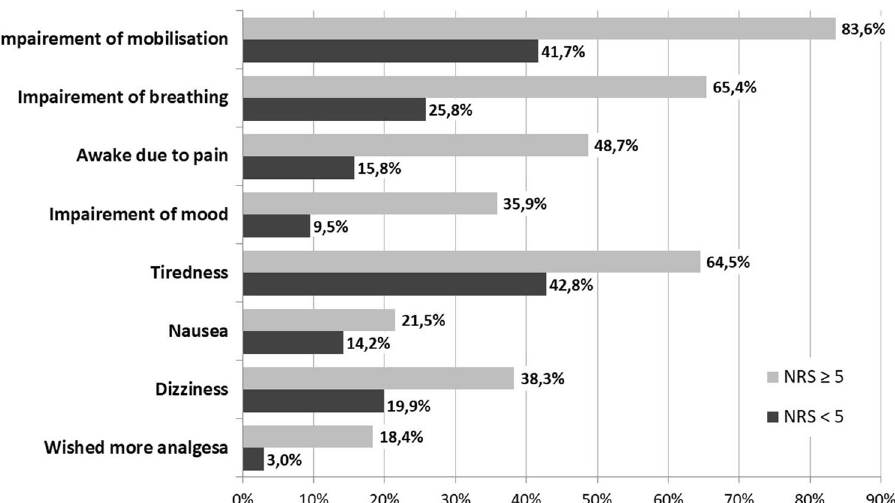
Figure 4. Comparison of side effects and impairment depending on pain score. Percentage of patients reporting side effects. Patients with high pain scores on 11-point numeric rating scale (NRS ≥ 5) on first postoperative day compared with patients showing low pain intensity (NRS < 5). Chi-Square-Test indicates a statistically significant difference for each comparison. (p <